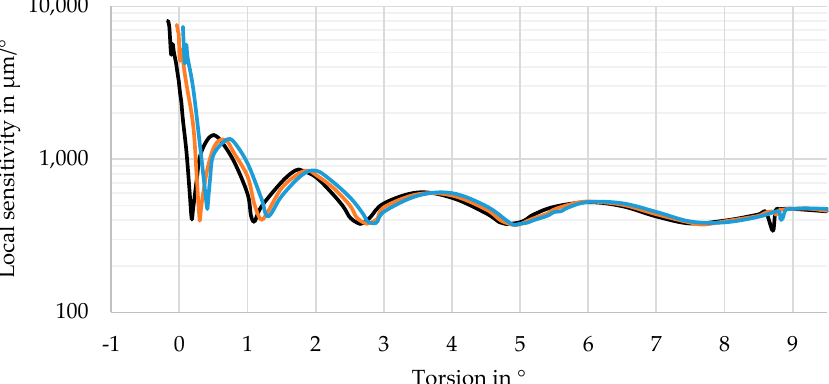
Figure 15. Influence of the exact orientation of the laser beam on the local sensitivity for torsion with 𝑒 = 1 mm . Lateral orientation of the laser beam input: black: 𝜚 = 67.45° , orange: 𝜚 = 67.5° (exact angle), blue: 𝜚 = 67.55° .